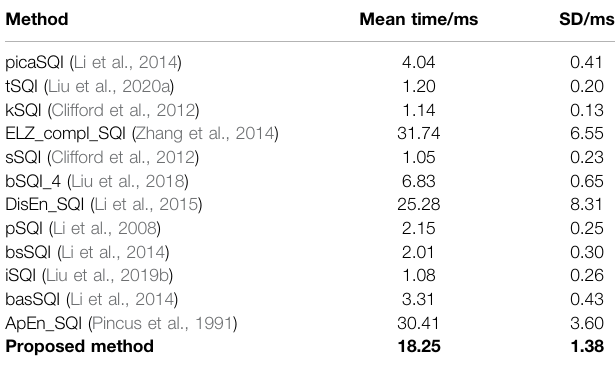
TABLE 5 | Mean time costs and standard deviation values of 12 SQIs and proposed method.